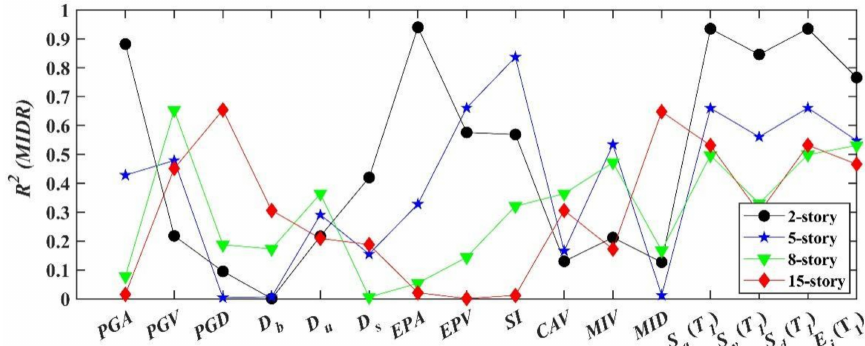
Figure 7. R 2 of IMs and MIDR , obtained via the cloud analysis of four typical structures subjected to pulse-like ground motions.